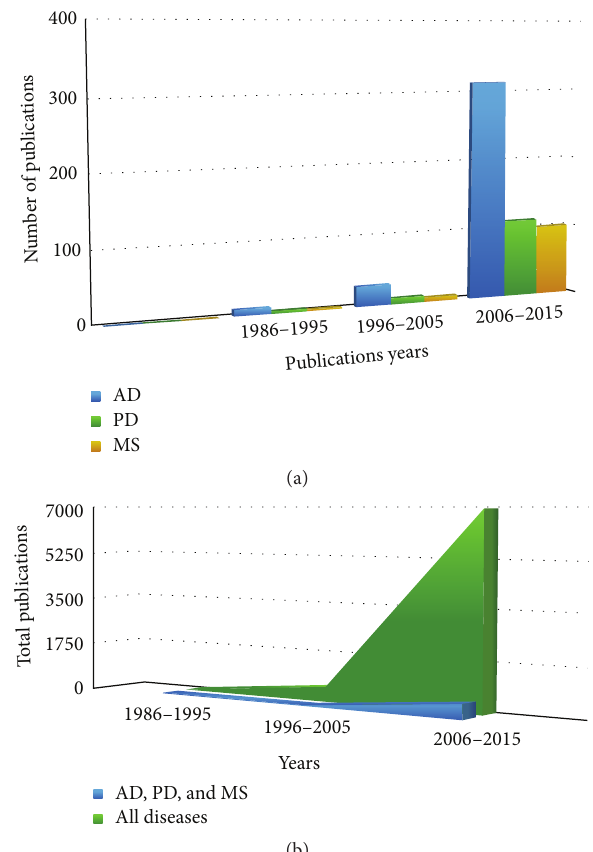
Figure 1: (a) Statistics over scientific publications around epigenet- ics related neurodegenerative (AD and PD), autoimmune diseases and other diseases using PubMed with queries ((“Parkinson’s dis- ease”) AND epigenetics), ((“Alzheimer’s disease”) AND epigenet- ics), and ((“Multiple Sclerosis”) AND epigenetics), last accessed on 7/20/2015. In (a), blue, green, and orange coloured bars represent the total number of publications, for AD, PD, and MS, respectively. (b) This figure illustrates the trend of research on other diseases around epigenetics compared to NDD (AD and PD) and autoimmune (MS) disease, where green coloured portion representing the studies on all sorts of diseases and blue portion covers only AD, PD, and MS related